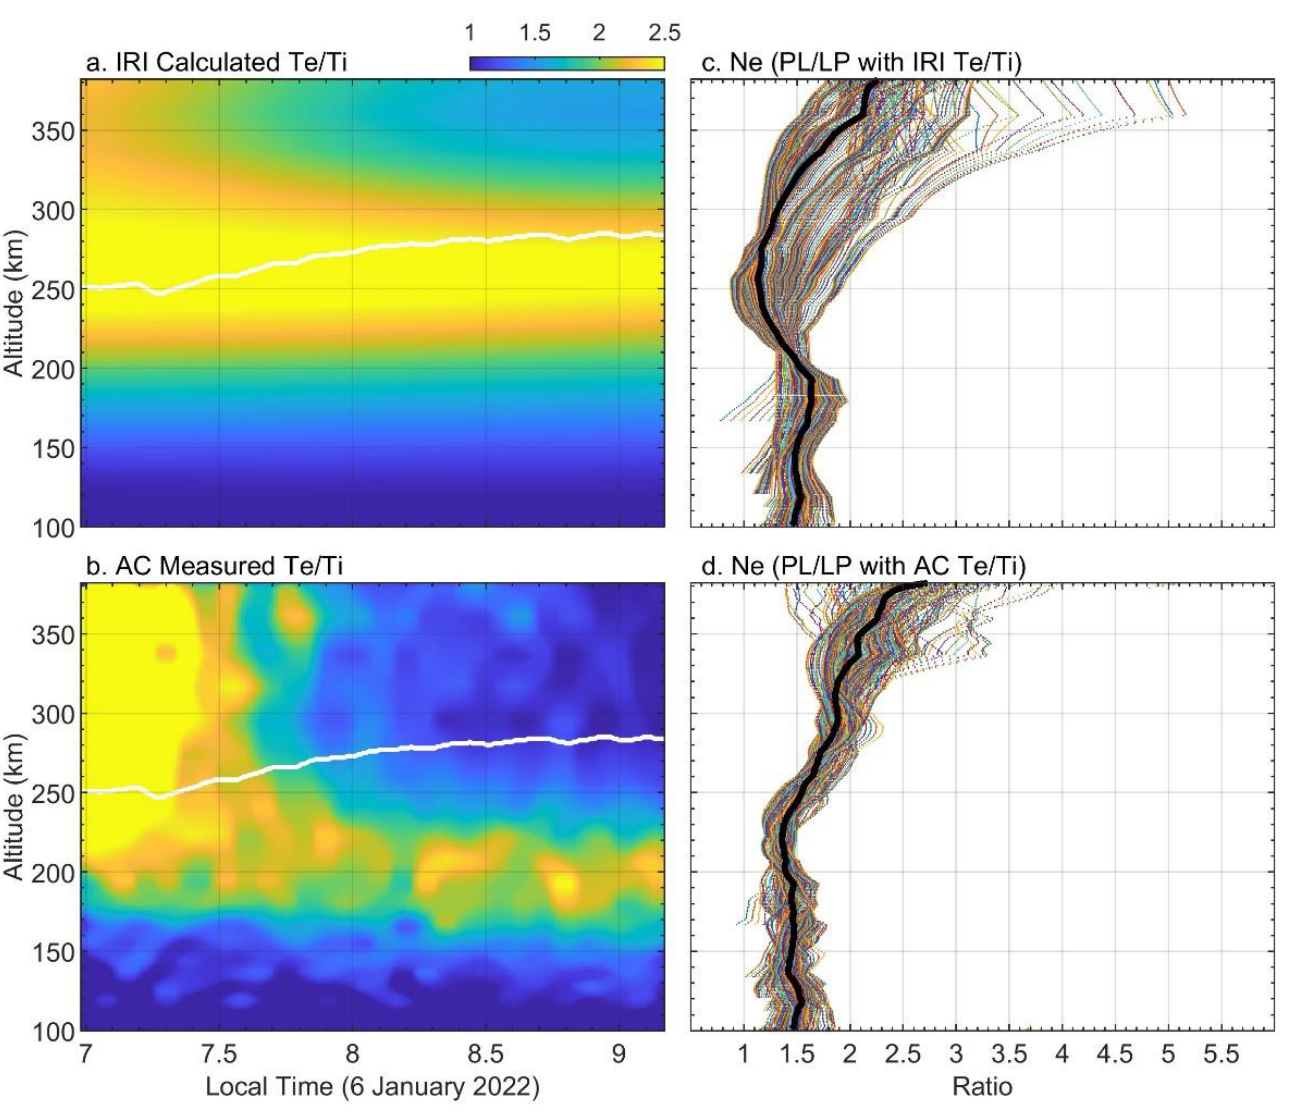
Figure 8. Local time and altitude variation of the T e / T i ratio made by the IRI model calculation ( a ) and SYISR alternating code (AC) experiment ( b ) during 6 January 2022. The white lines in subplots ( a , b ) are the ionospheric peak heights derived from PL measurements. Subplots ( c , d ) are the electron density ratio of plasma line (PL) direct measurements to the 100 μs long pulse (LP) derivations before calibration using radar equation on the basis of T e / T i corresponding to subplots ( a , b ), respectively. The thick black lines are the corresponding mean profiles, while the thin color lines represent the profiles of different local times.